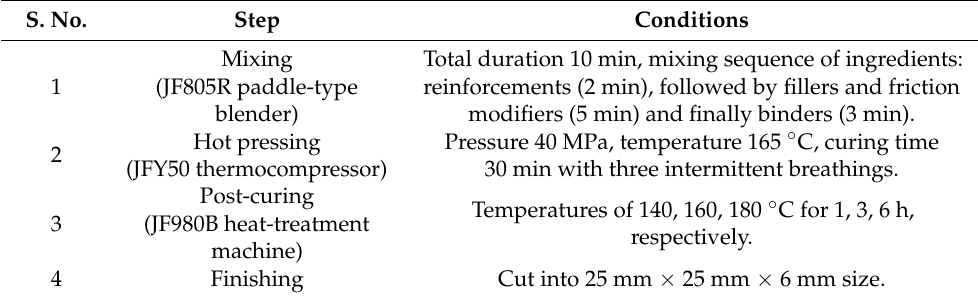
Table 2. Detailed conditions involved in the fabrication process of the friction